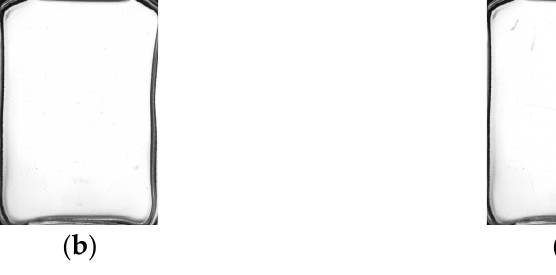
Figure 13. Comparison of background modelling results. ( a ) Original image; ( b ) Background model of this paper; ( c ) Background model of the literature [35].